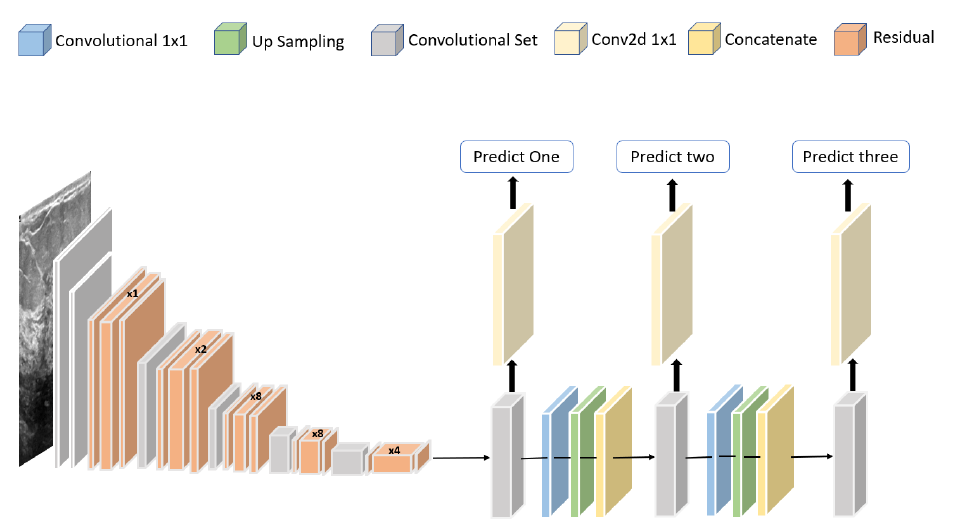
Figure 11. Structure of the modified DarkNet-53 deep model proposed in